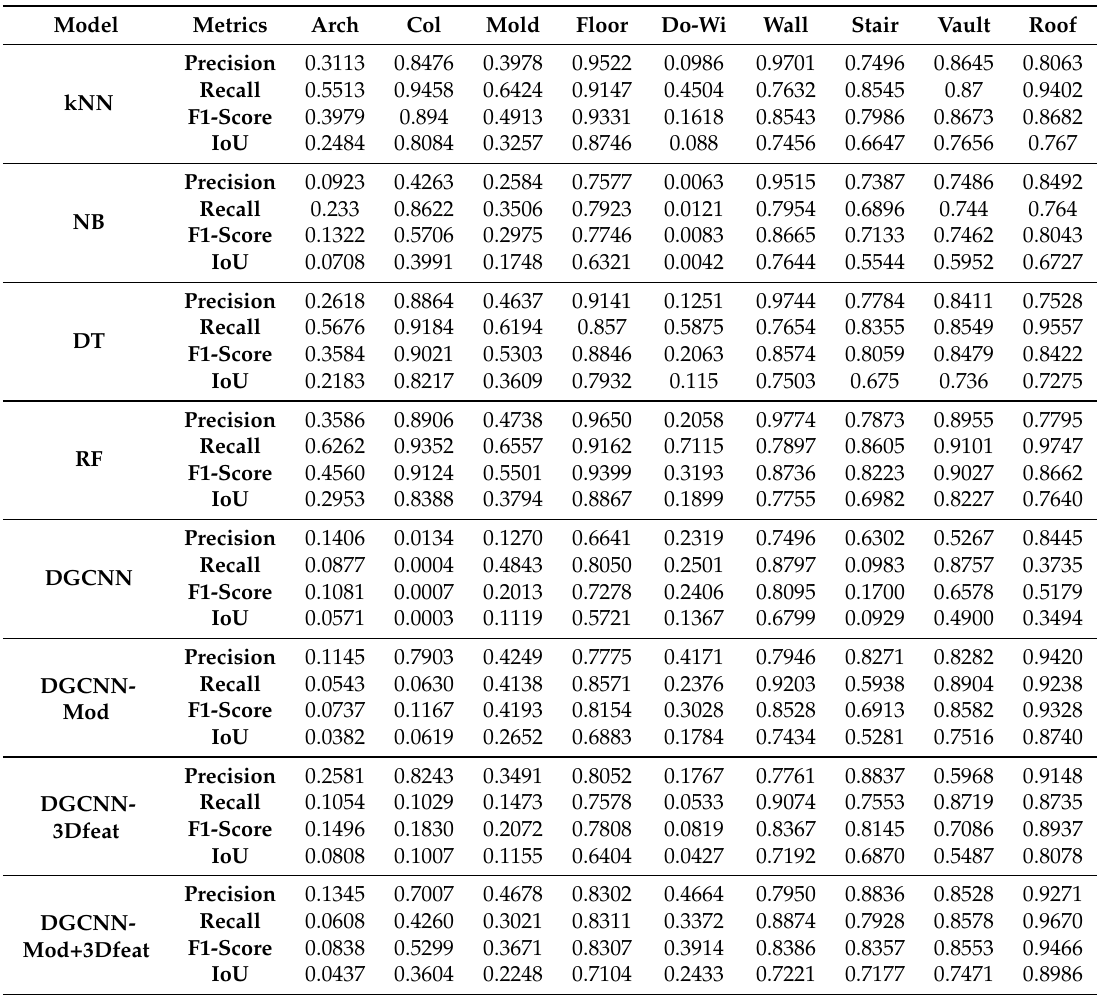
Table A2. Tests performed on the SMV scene. For the DL approach 10 scenes as training, 1 for validation (5_SMV_chapel_1) and 1 for test.